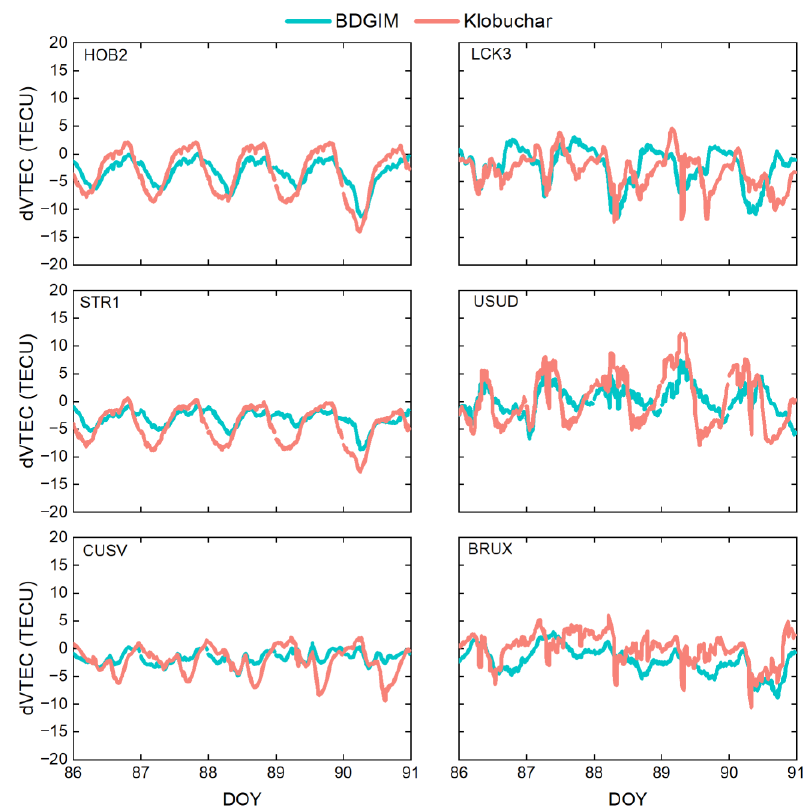
Figure 3. The dVTEC of BDGIM and Klobuchar relative to GIM.